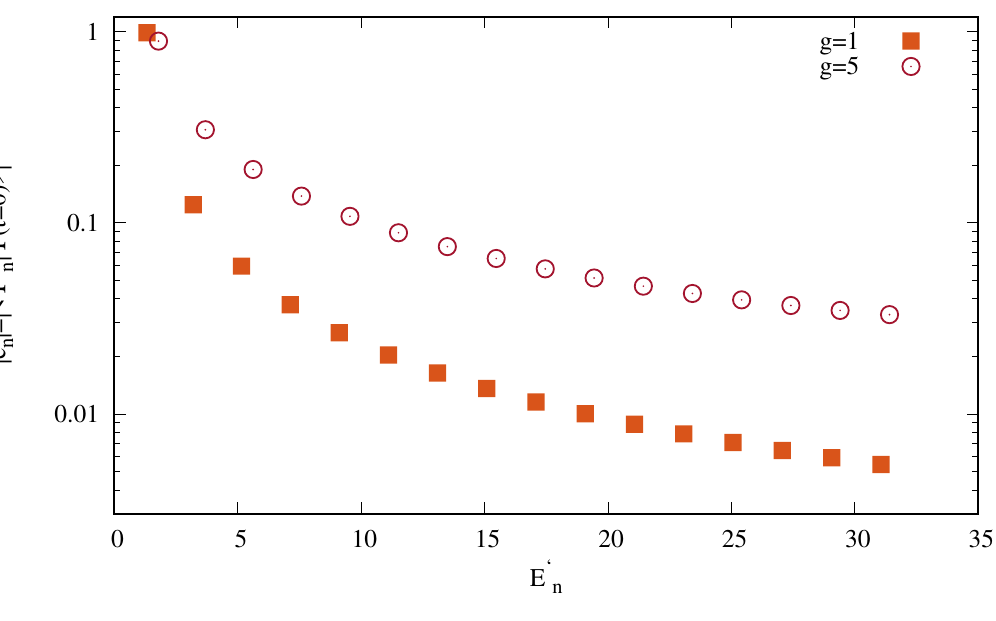
Figure 14. Projection of the initial ground state for g = 0 into the eigenstates of g = 1 and g = 5 as a function of its energy, for a two particles systems with zero total spin. The y axis is in logarithmic